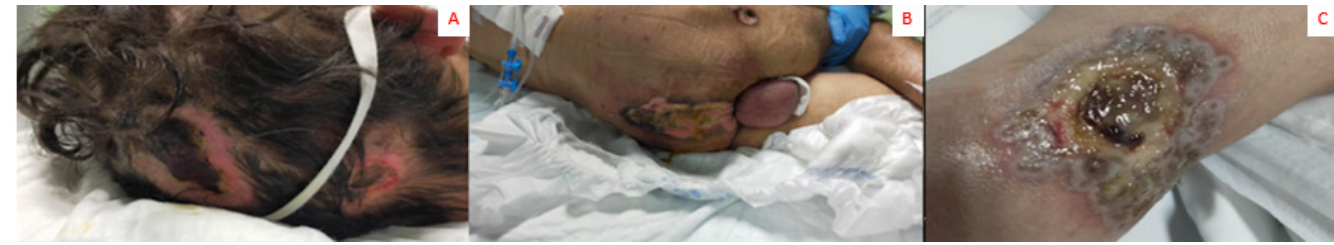
Figure 4. ( A – C )New typical mucocutaneous lesions on ulcer borders, deep scalp ulcers, and gluteal- sacral deep ulcer (days 87–97).